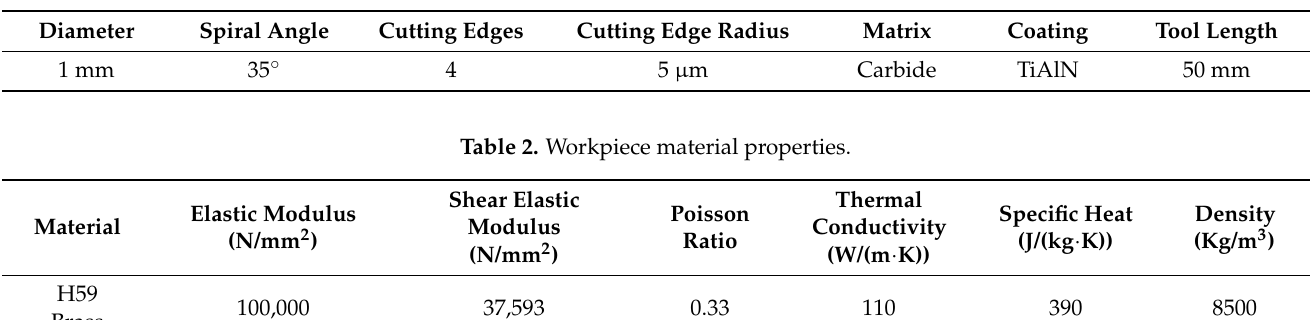
Table 1. Micro milling cutter properties.